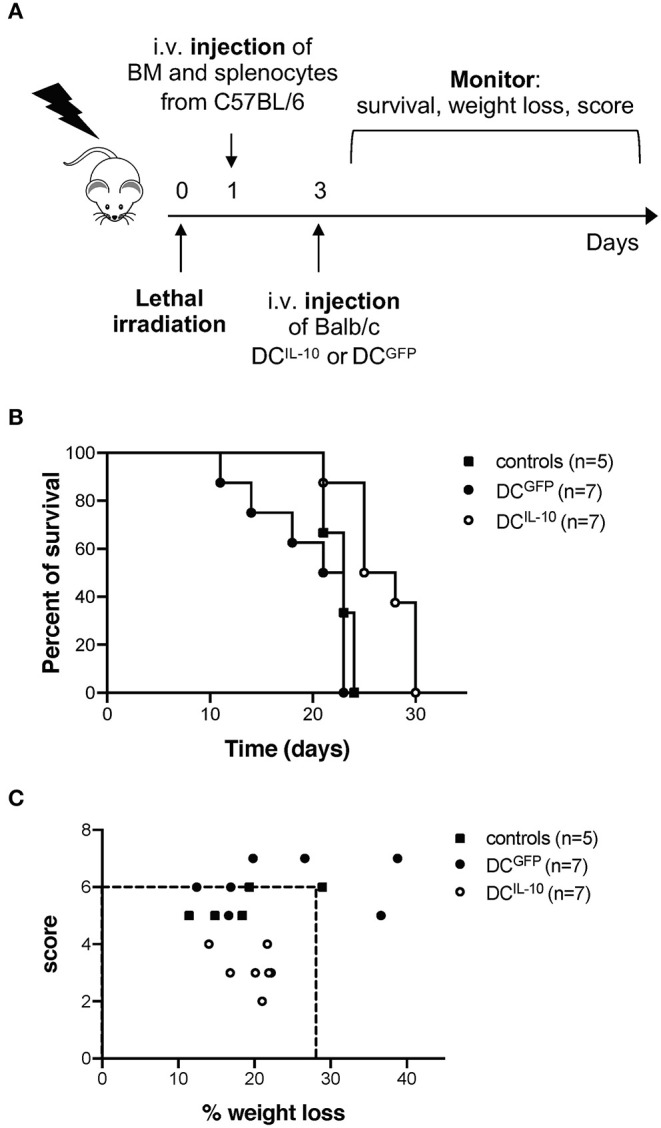
Adoptive transfer of DCIL−10 delays acute graft-vs. host disease. Female Balb/c mice were lethally irradiated and then intravenously injected with 107 BM cells and 5 × 106 splenocytes from female C57Bl/6 mice the day after. On day 3, mice were left untreated (n = 5) or were adoptively transferred with 2 × 106 DCGFP (n = 7), or 2 × 106 DCIL−10 (n = 7). Survival, weight loss and score of mice was monitored every other day. (A) Experimental design is depicted. (B) Survival of mice was observed over time. One representative experiment out of three is shown. (C) The score (fur, hunch, skin lesion, mobility) and the weight loss of mice at day 25 is represented, dashed lines represent the criteria for euthanasia (score >6 or > 25% of weight loss). One representative experiment out of three is shown.